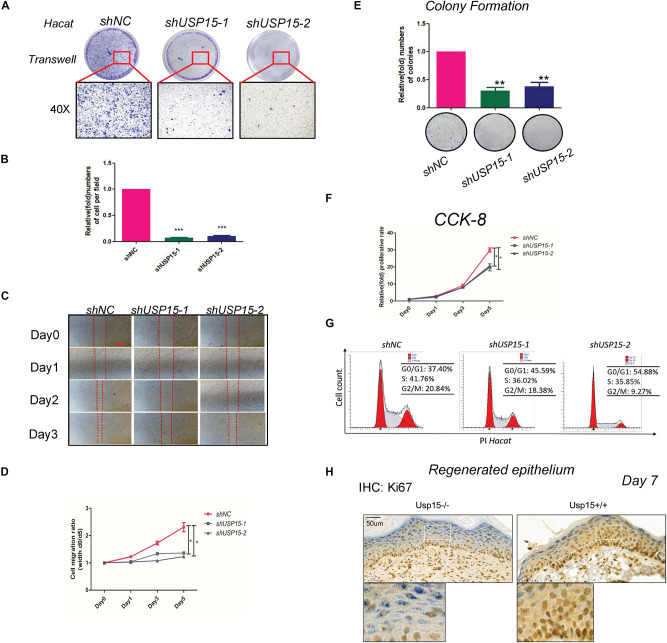
Loss of USP15 inhibited proliferation and migration in vitro. (A) A transwell assay was performed to determine the migratory ability of the USP15-silenced keratinocytes (HaCaT). (B) Quantification of the numbers of transferred cells. The colony number in the empty vector group was set as 100%. All experiments were performed in triplicate, and the relative cell numbers are shown as the mean ± SEM. *p < 0.05, **p < 0.01, ***p < 0.001. (C) A wound healing assay was performed to determine the migratory ability of the USP15-silenced keratinocytes (HaCaT). Scale bar: 50 μm. (D) Quantification of the wound recovery rate in the wound healing assay. All experiments were performed in triplicate, and the relative cell migration ratio is shown as the mean ± SEM. *p < 0.05. (E) A colony formation assay was performed to determine the colony formation ability of the USP15-silenced cells. The colony number in the shNC group was set as 100%. All experiments were performed in triplicate, and the relative colony formation rates are shown as the mean ± SEM. *p < 0.05, **p < 0.01. (F) A CCK-8 assay was performed to determine the proliferative rate of the USP15-silenced cells. The OD value of Day 0 was set as 100%. *p < 0.05. (G) Cell cycle analysis by flow cytometry was performed to determine the percentage of cells in the different cell cycle phases. The X-axis represents the FL2 channel-captured PI staining signals, and the Y-axis represents the cell counts. (H) Immunohistochemistry of Ki67 in the regenerated keratinocyte in Usp15 knockout mice and their wild-type littermates at 7 days after establishing excisional wound splinting model. Scale bar: 50 μm.